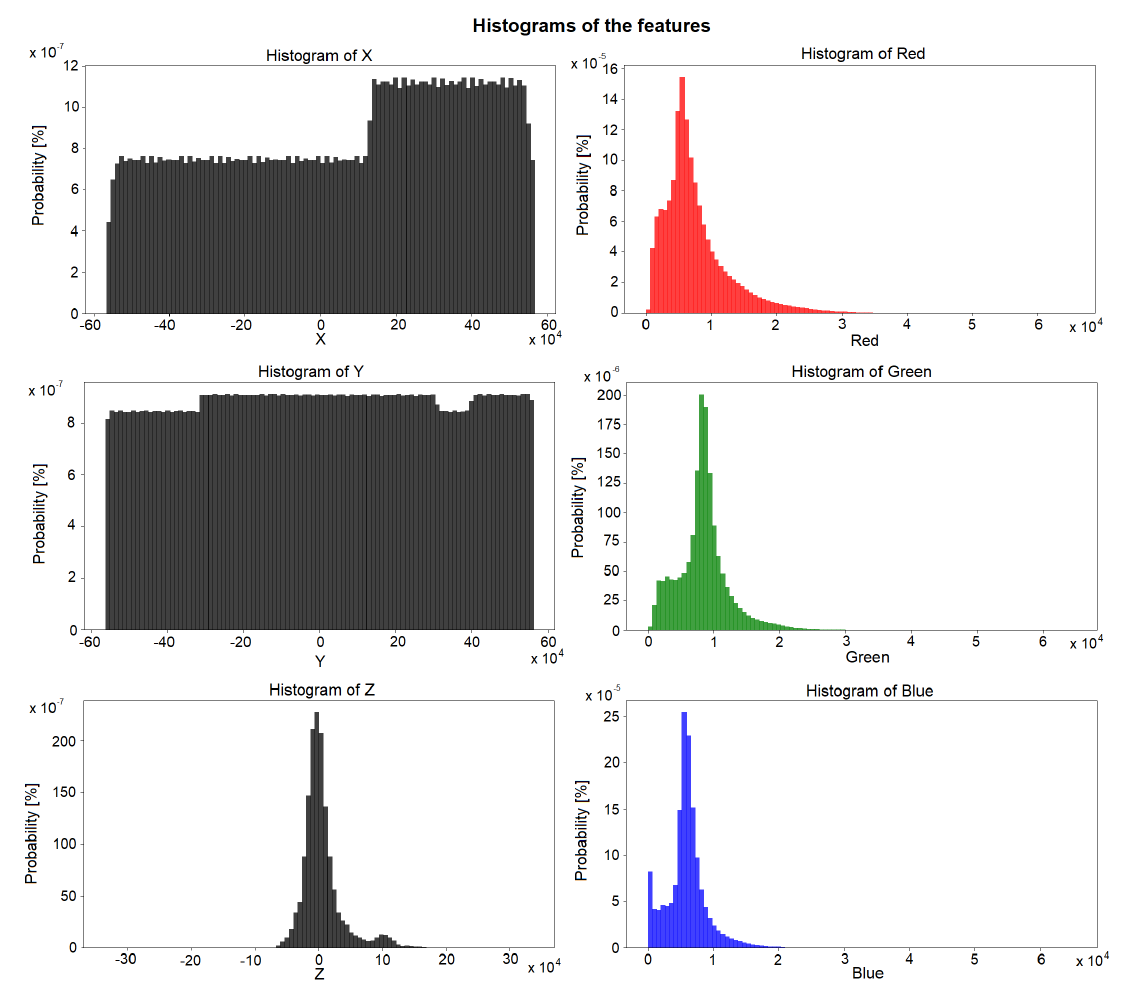
Figure 5. Training set feature